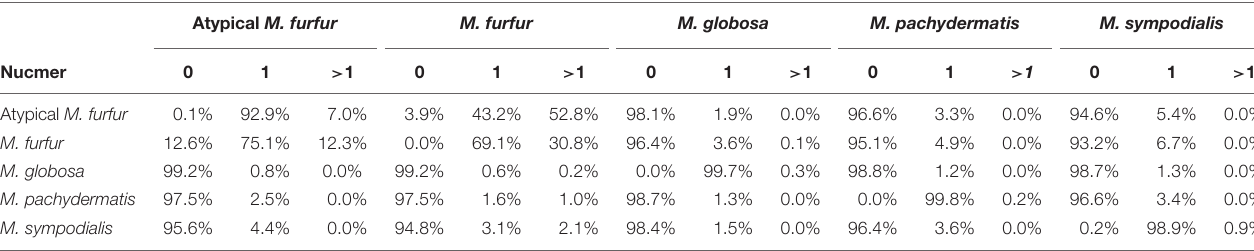
TABLE 2 | Percentage of the genome with zero (0), one (1), or multiple ( > 1) matches in the Nucmer genome alignment (Boetzer and Pirovano, 2012) with a maximum gap between two adjacent matches in a cluster of 90 bp and a minimum length of a maximal exact match of 20 bp. Atypical M. furfur